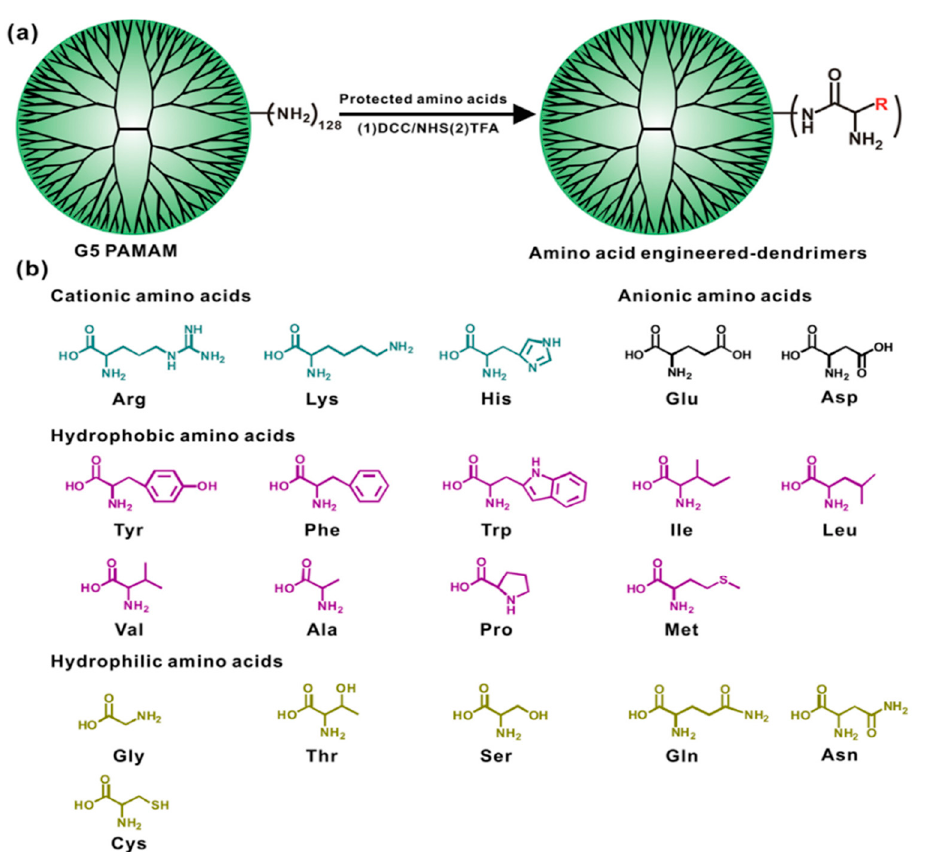
Figure 43. ( a ) Synthesis of G5, PAMAM dendrimers engineered with twenty common amino acids using a facile condensation reaction and ( b ) structures of the conjugated amino acids. The amino acids are divided into cationic, anionic, hydrophobic and hydrophilic amino acids according to the residue group. Reprinted with permission from [94]. Copyright 2016 Elsevier.